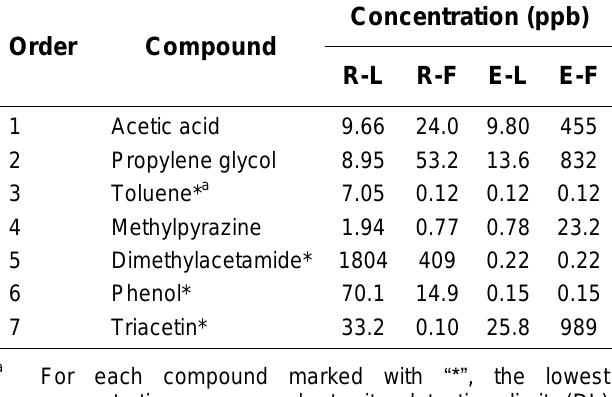
Summary of Compounds Emitted from Filter Fractions of Different Cigarettes after Passing 1 L of Pure N 2 through Torn-Apart Filter Concentration (ppb) Order Compound R-L R-F E-L E-F Acetic acid 9.66 Propylene glycol 8.95